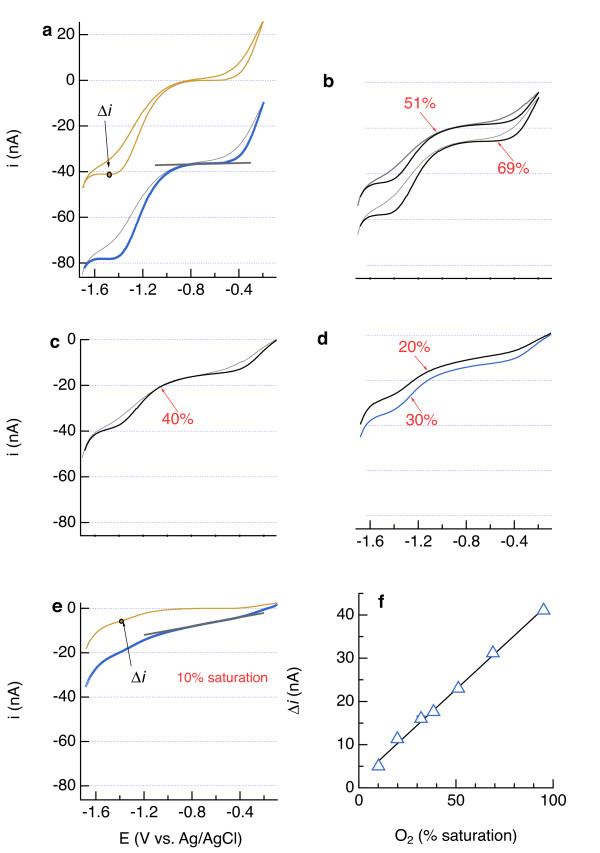
 Cyclic voltammograms during reduction of O2to H2O2and H2O2to H2O in artificial seawater at different degrees of oxygen saturation. In a and e, baselines are shown in black and background-subtracted data in brown, from which the inflection point after H2O2 reduction was plotted vs. O2 concentration independently measured with an amperometric membrane electrode (f). O2 concentration was adjusted by varying the proportions of air and N2 blanketing the flask.